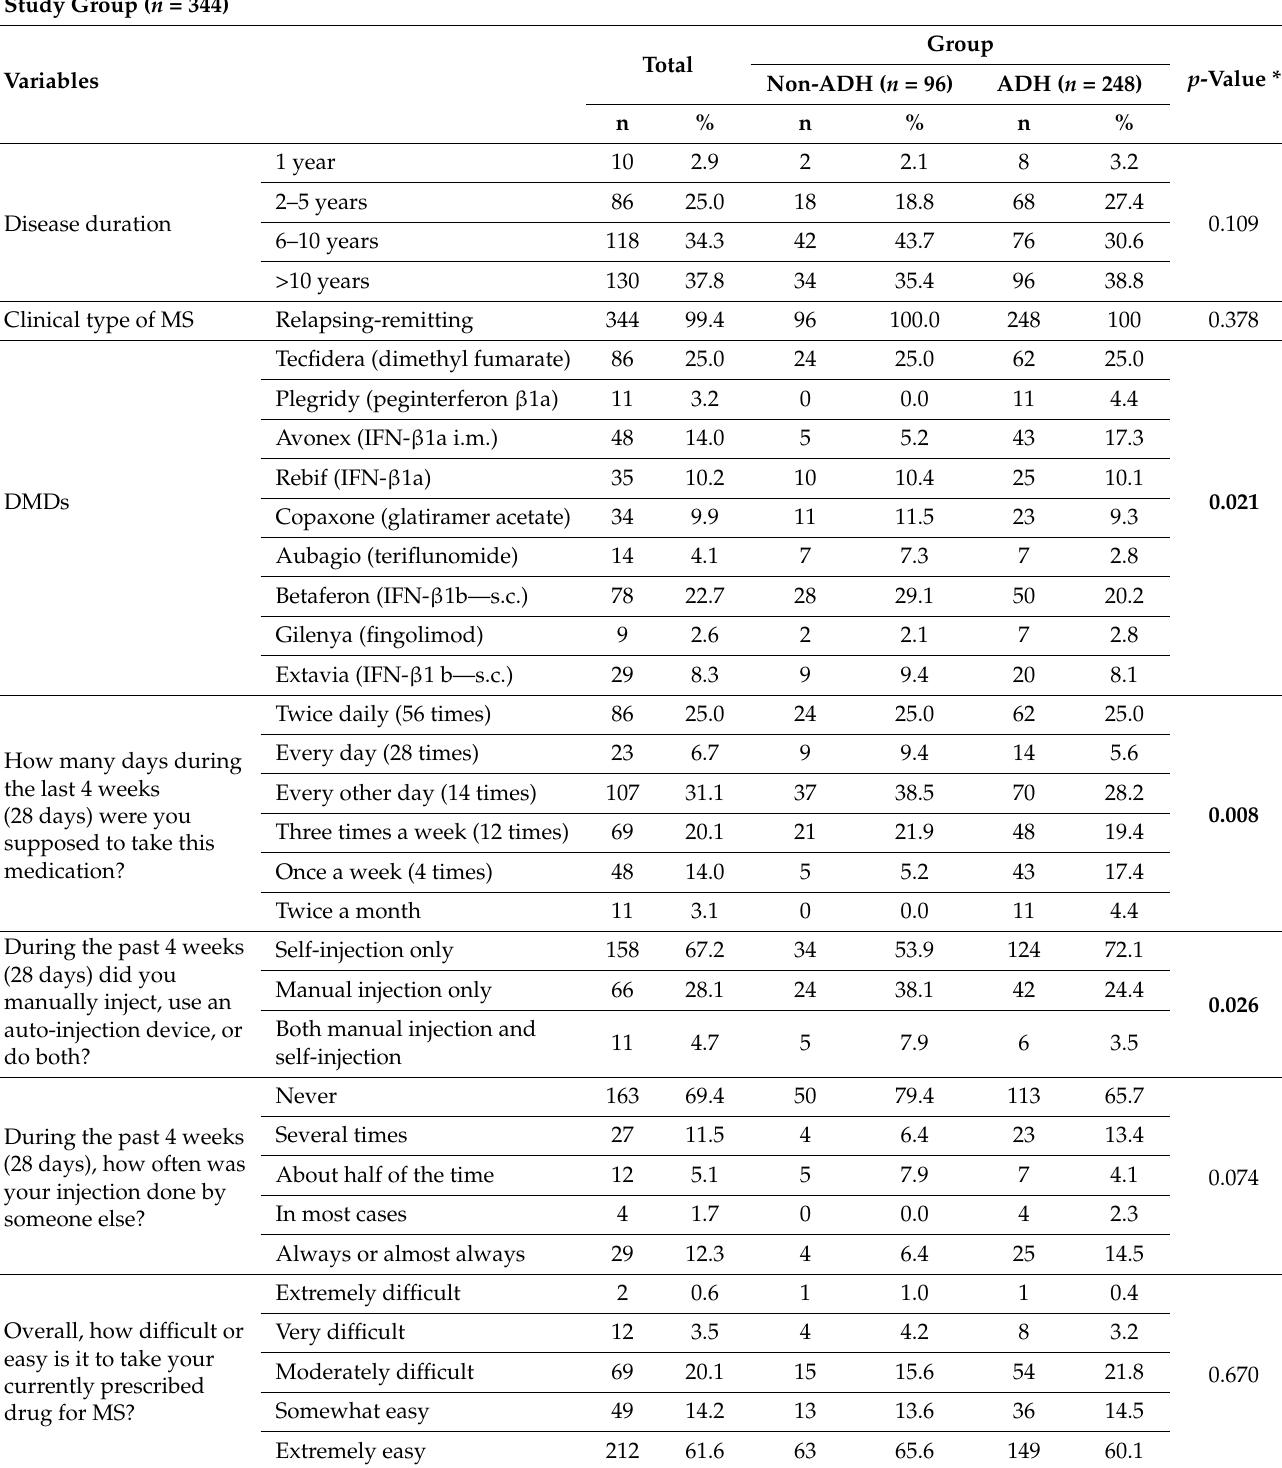
Table 2. The comparison regarding the MS type and treatment used in adherent and non-adherent